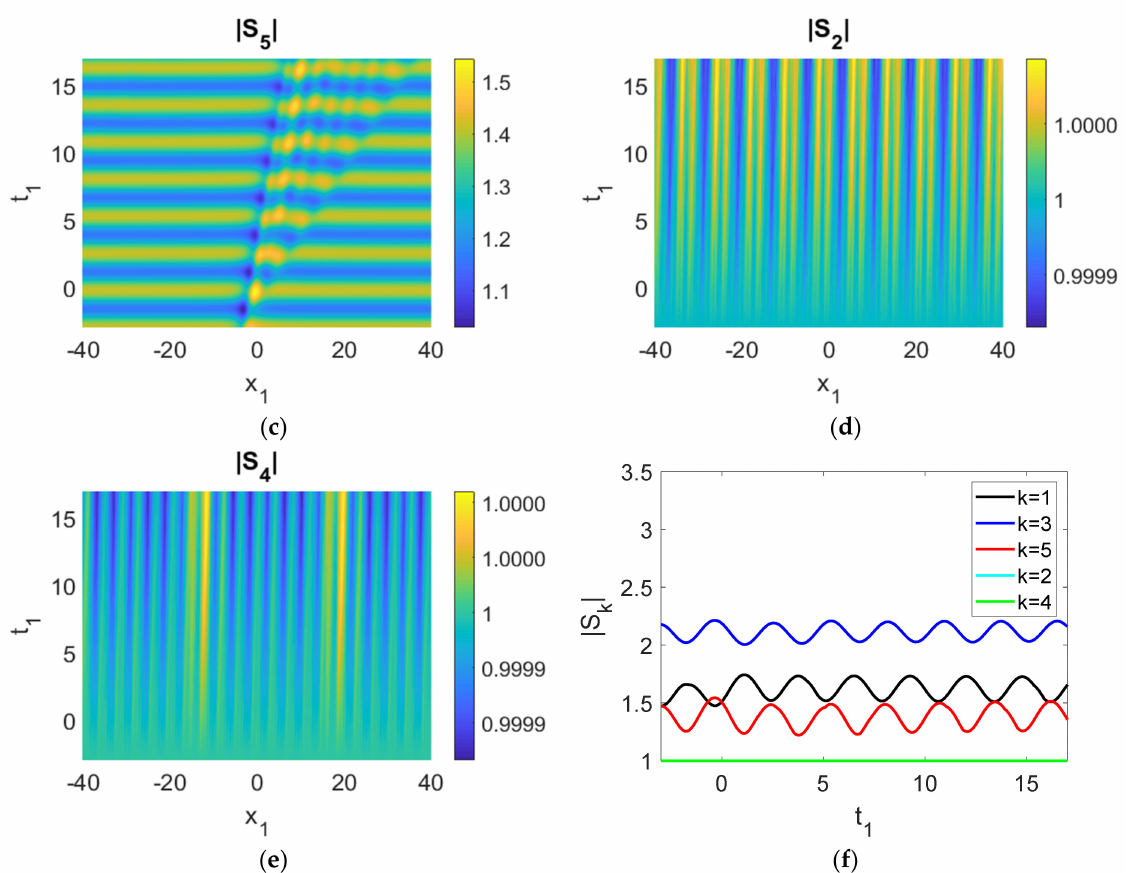
Figure 4. ( a – e ) Control experiment (only | S 1 |, | S 3 | and | S 5 | oscillate, | S 2 |, | S 4 | mostly unchanged); ( f ) time history of the moduli of the envelopes, | S k |. Parameters used were c g 1 = 2, c g 3 = 1, c g 5 = 0.5, c g 2 = 0.1, c g 4 = 0.1, γ 1 = − 0.1, γ 3 = 0.1, γ 5 a = 0.1, γ 2 = 0, γ 4 = 0,